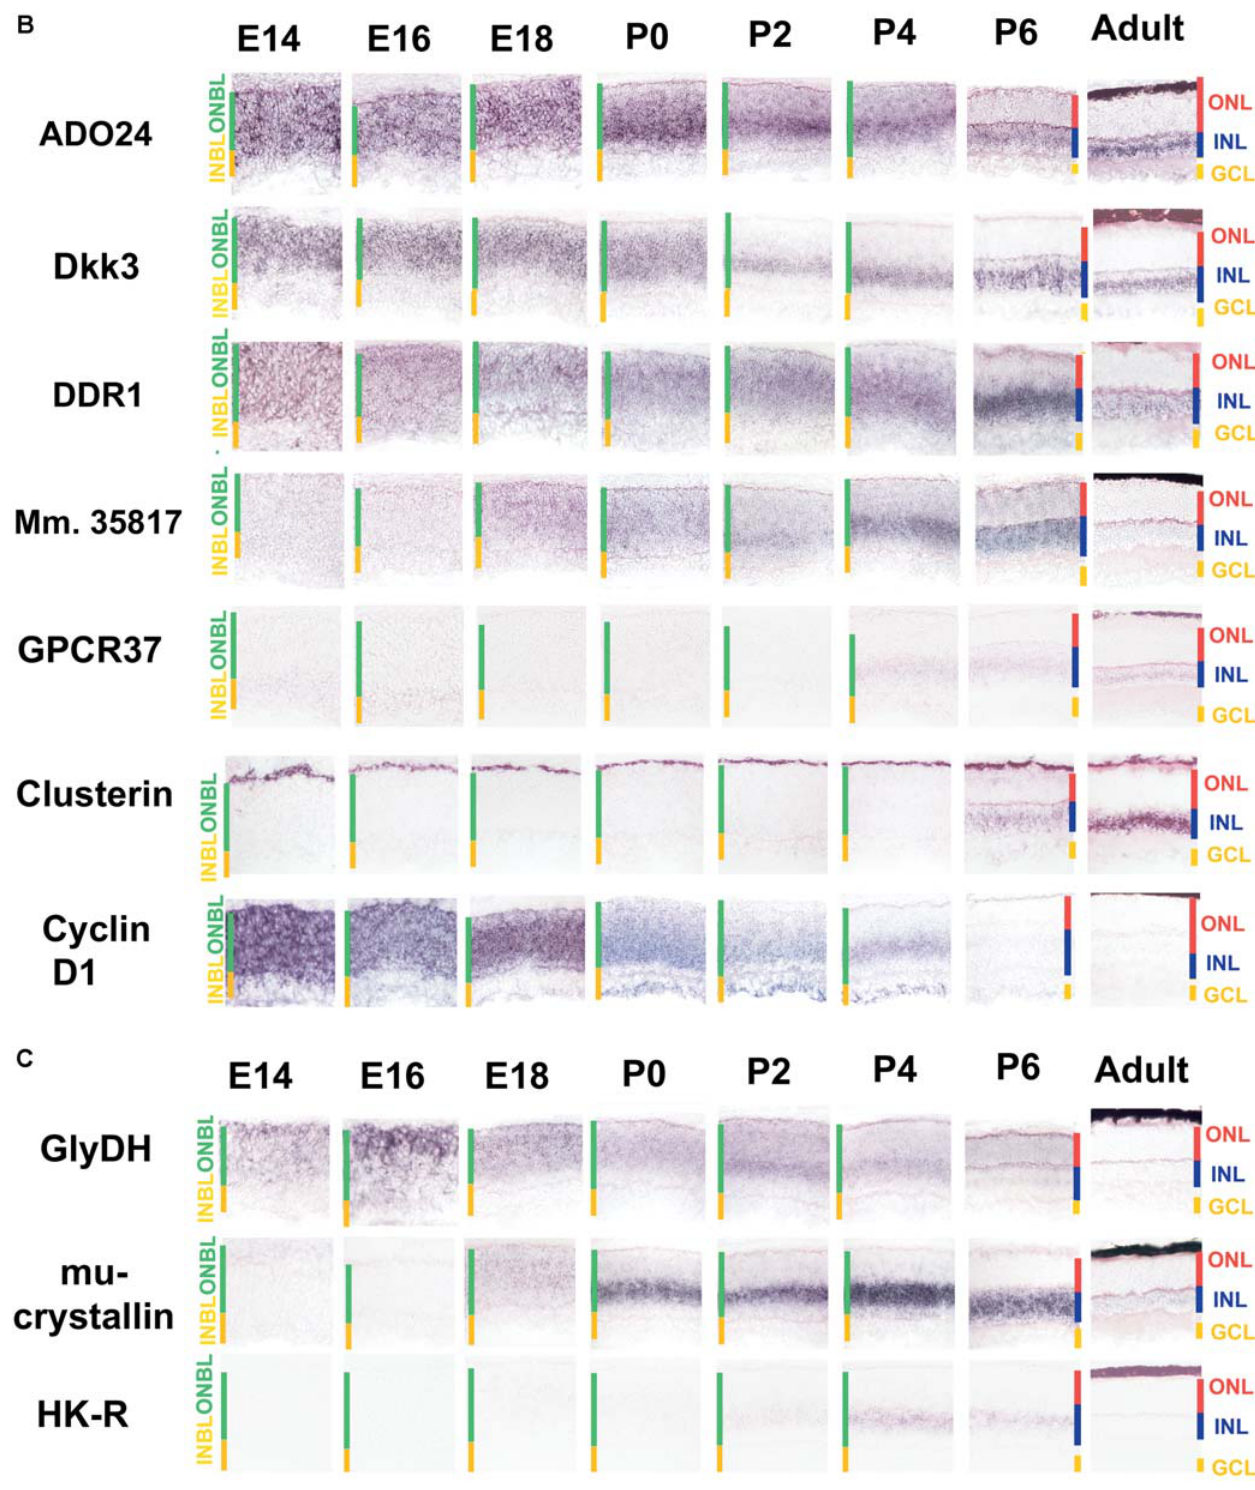
FIgure 5 Mu¨ ller glia. It was transcribed in a head-to-head fashion, and largely coexpressed, with Six3. This transcript showed extensive alternative splicing, and while one splice form contained a potential ORF of greater than 100 amino acids,